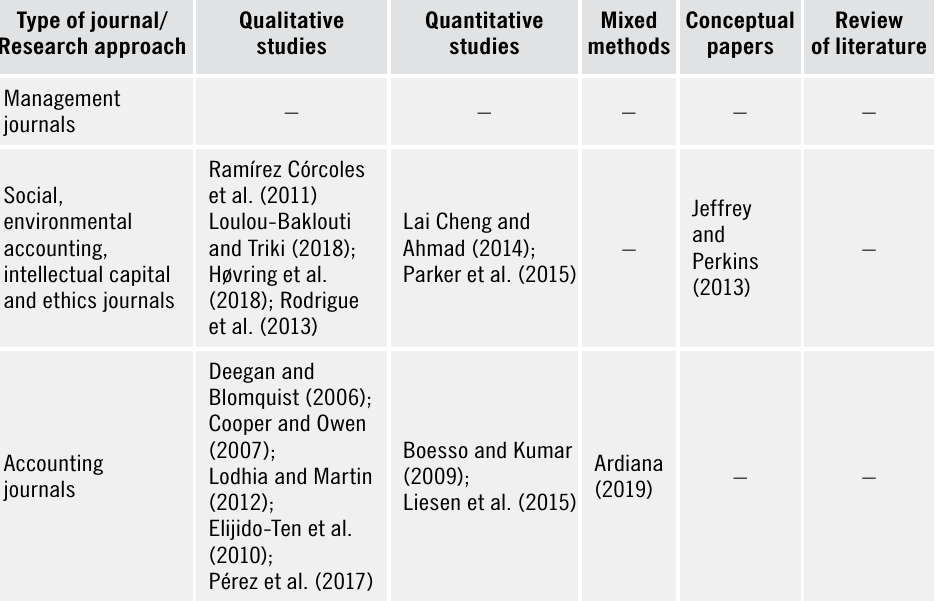
Table 3. Reviewed studies on stakeholder influence on social disclosures, by journal type and research